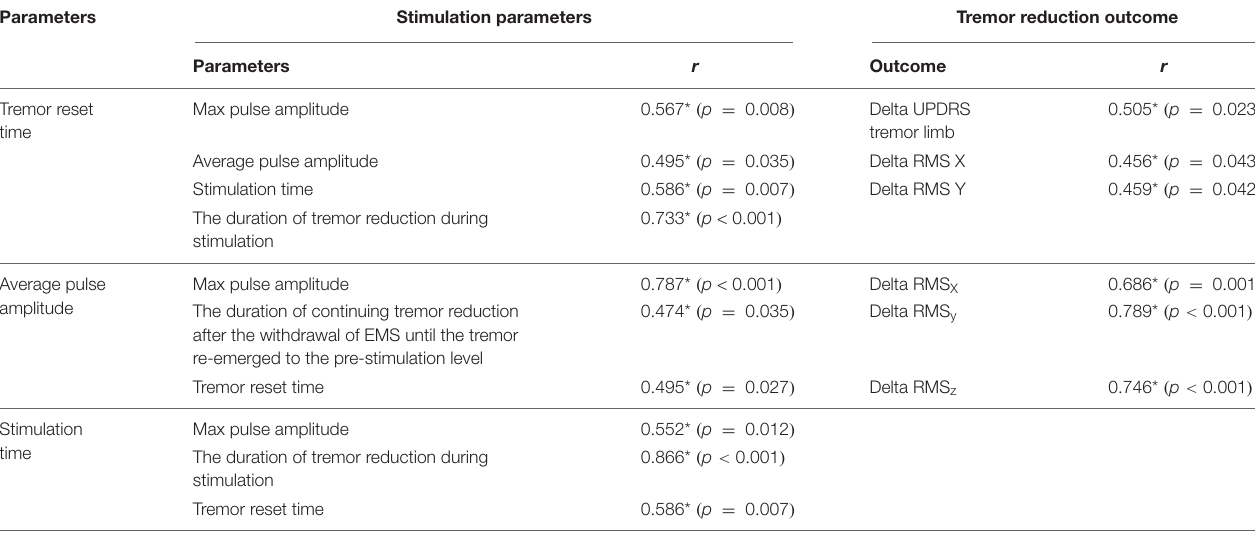
TABLE 5 | Correlation of stimulation parameters and tremor reduction outcomes.